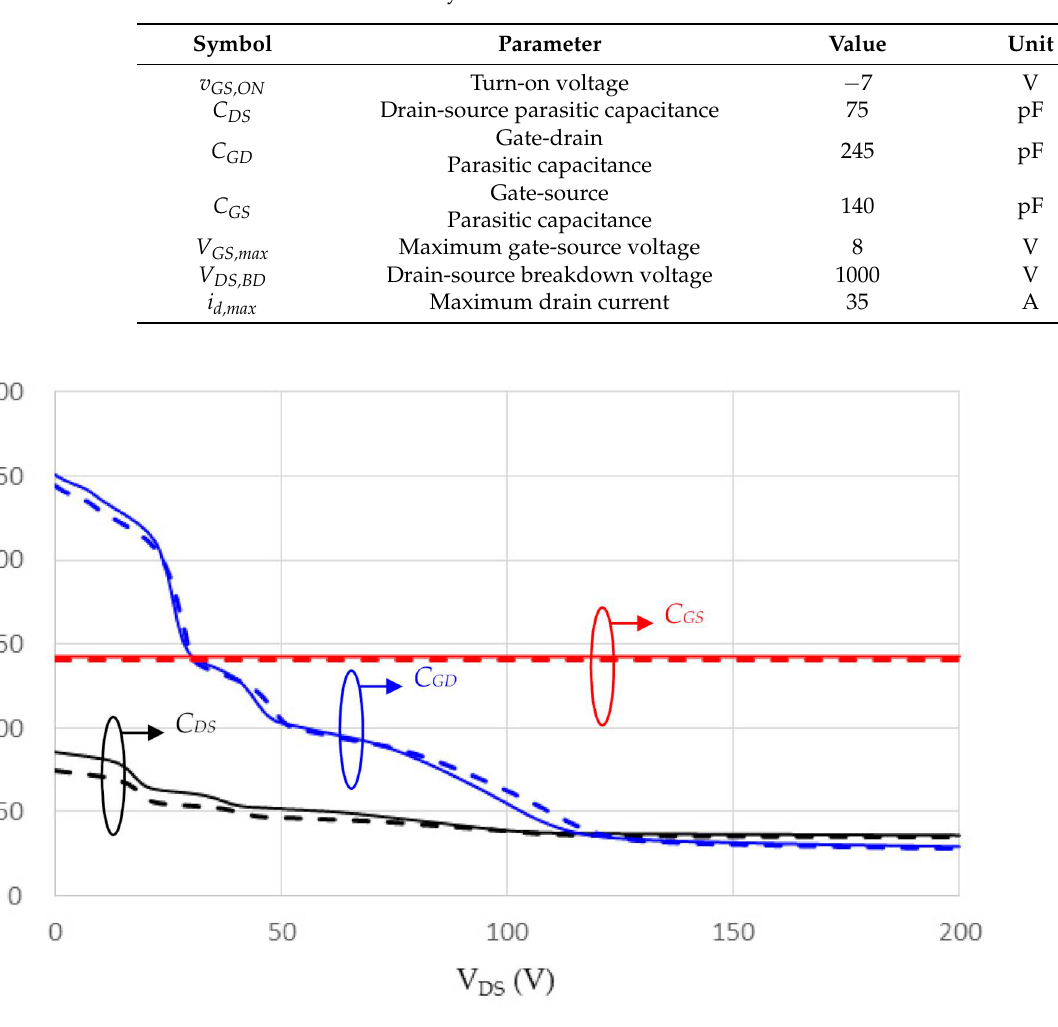
Figure 8. Parasitic capacitance measurement of the D-mode GaN HEMT. C GS (red curve), C GD (blue curve), C DS (black curve), parasitic capacitance under 5 MHz (solid line), under 4 MHz (dashed